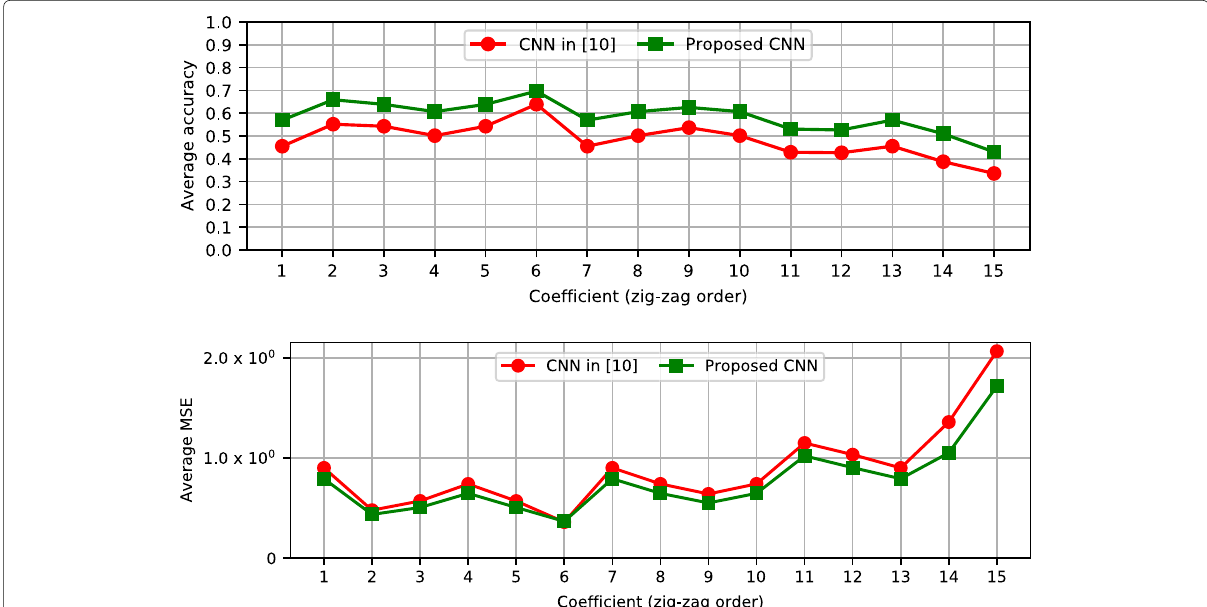
Fig. 10 Performance of the estimator on DJPEG low resolution images from Dresden dataset ( QF 2 = 90). Average accuracy (top) and MSE (bottom) of the estimation for each of the 15 DCT